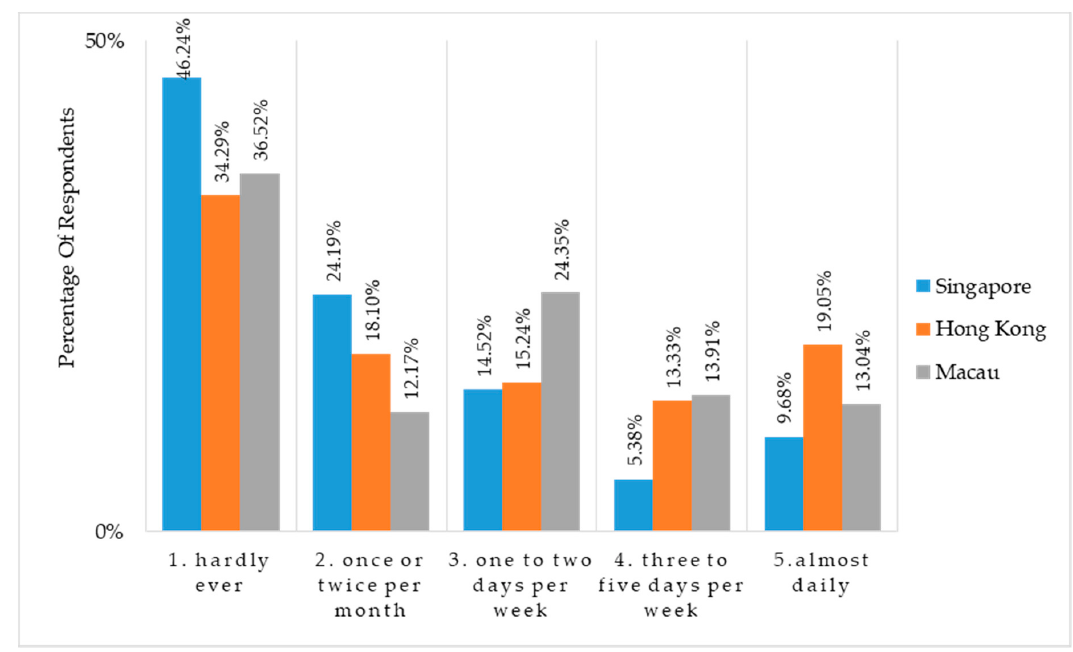
Figure 2. Frequency of drinking bottled water on campus.